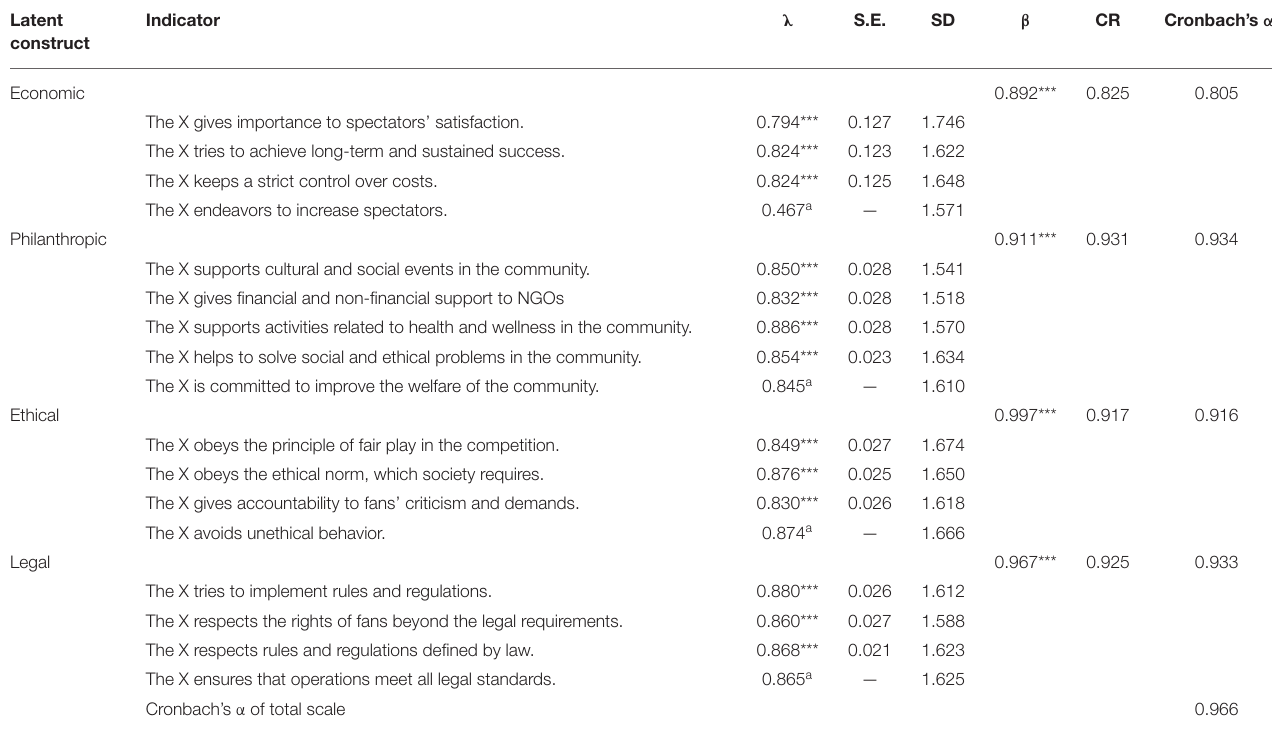
TABLE 5 | Confirmatory factor analysis for the CSR